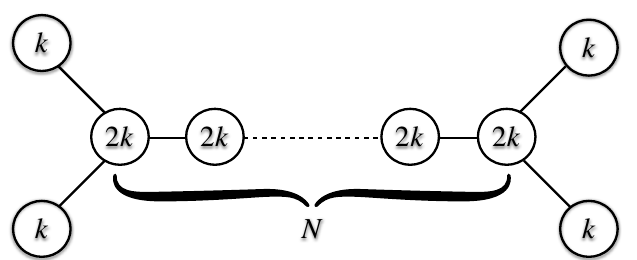
Figure 15: Upon a circle compactification of the non minimal ( D , D ) conformal mat- ter, k M5 branes probing D singularity, with proper holonomies turned on one ob- N + 3 tains a 5d effective quiver description shaped as the affine Dynkin diagram of D N + 3 with SU ( k ) and SU ( 2 k ) gauge groups as depicted here. Upon compactification to four dimensions this five dimensional description gives a puncture with symmetry SU ( k ) 2 × SU ( 2 k ) N × SU ( k ) 2 with a pattern of moment map operators corresponding to the Dynkin